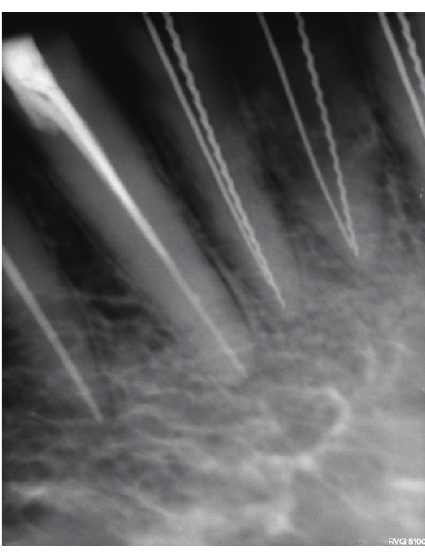
Figure 3: Radiograph showing two different instruments (“H” file and Reamer) in two canals in 31 and 32.